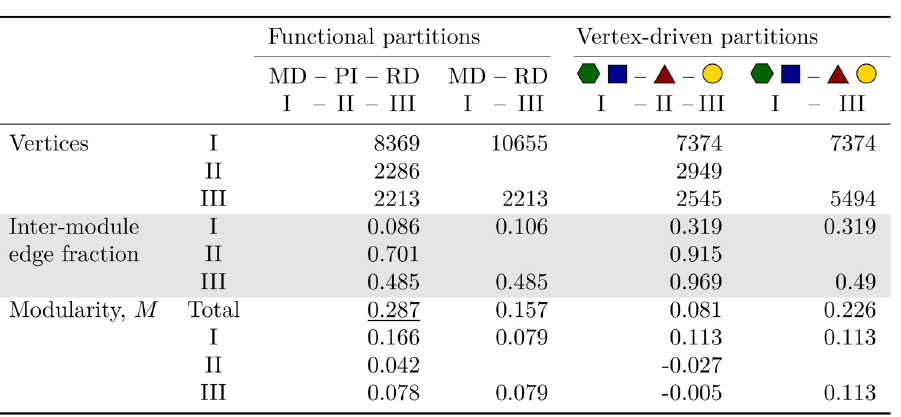
Fig 4. Topological properties of the functional and vertex type-driven network partitions. The functional partitions are denoted by the respective modules, metabolic domain (MD), regulatory domain (RD) and protein interface (PI). The vertex type-driven partitions are represented by the comprising vertex types, reaction (green hexagon), compound (blue square), gene (yellow circle), and protein (brown triangle). For each property, the module- specific coefficients and contributions (I, II, III) are presented, respectively. For the modularity, M , the overall network coefficient (Total) is shown as well as the best coefficient is underlined, the module-specific values correspond to the terms in the sum of Eq